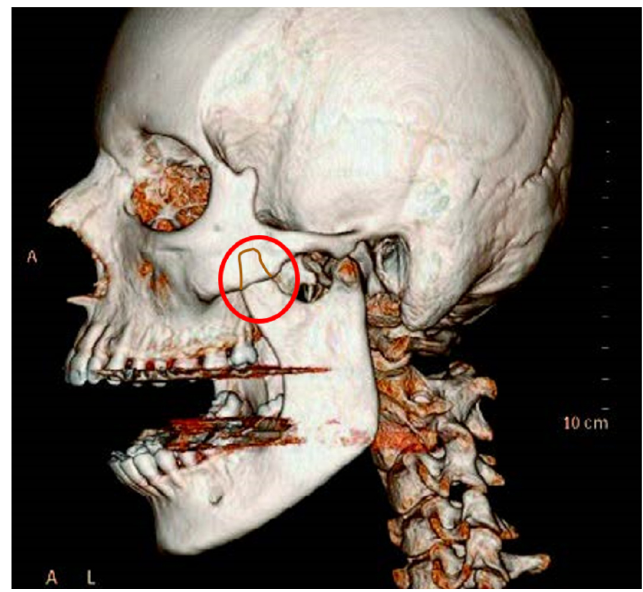
Figure 3. Pathological hypertrophy of the coronoid process of the mandible.